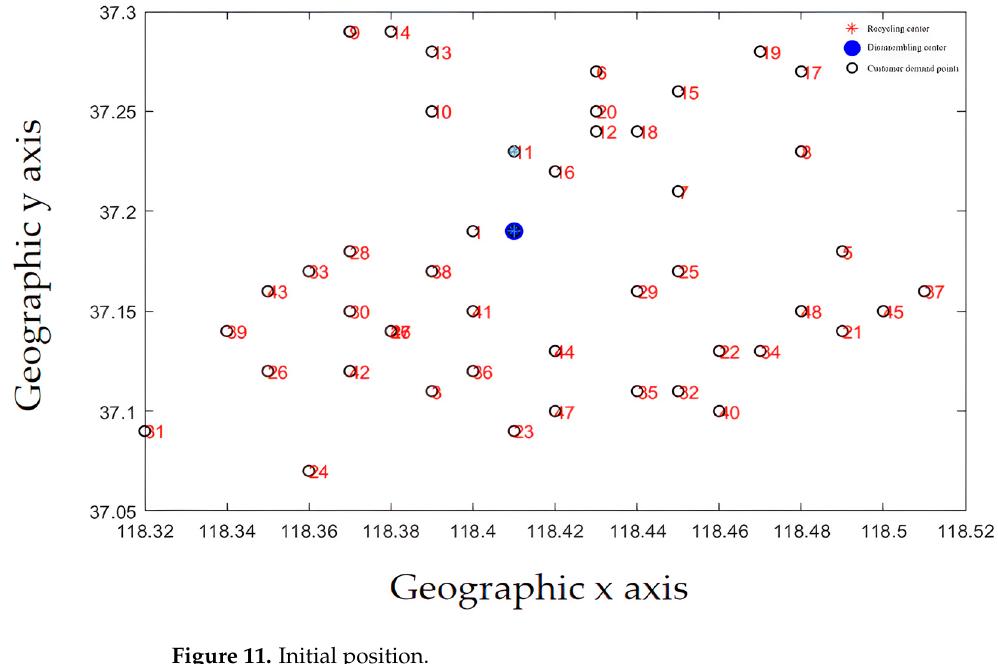
Figure 11. Initial position.